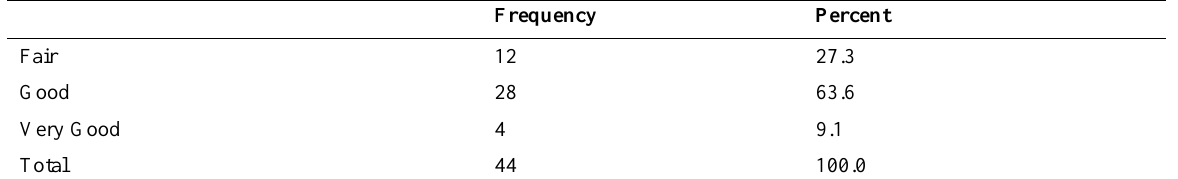
Table 6: Level of Service Delivery